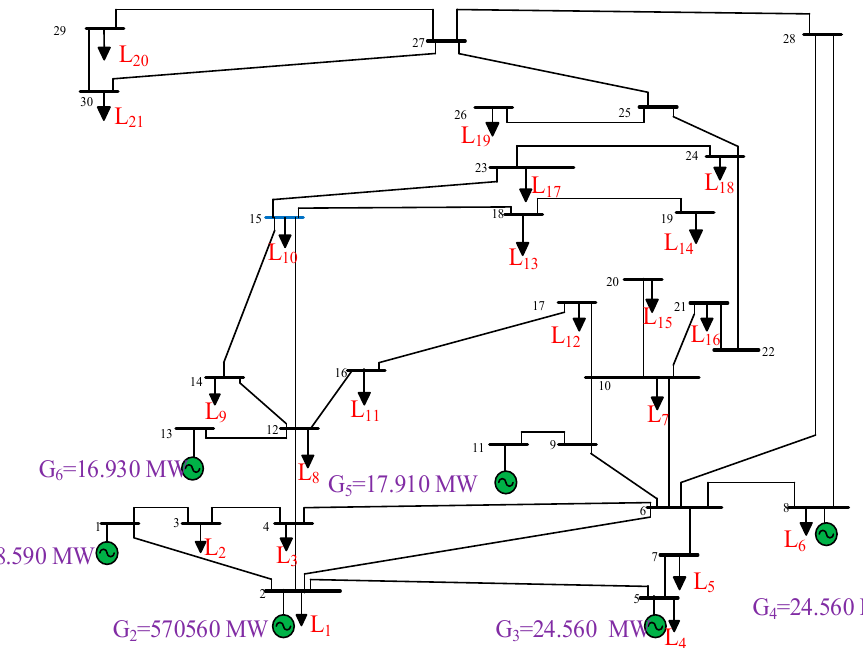
Figure 4. Single line diagram of modified IEEE 30-bus system.